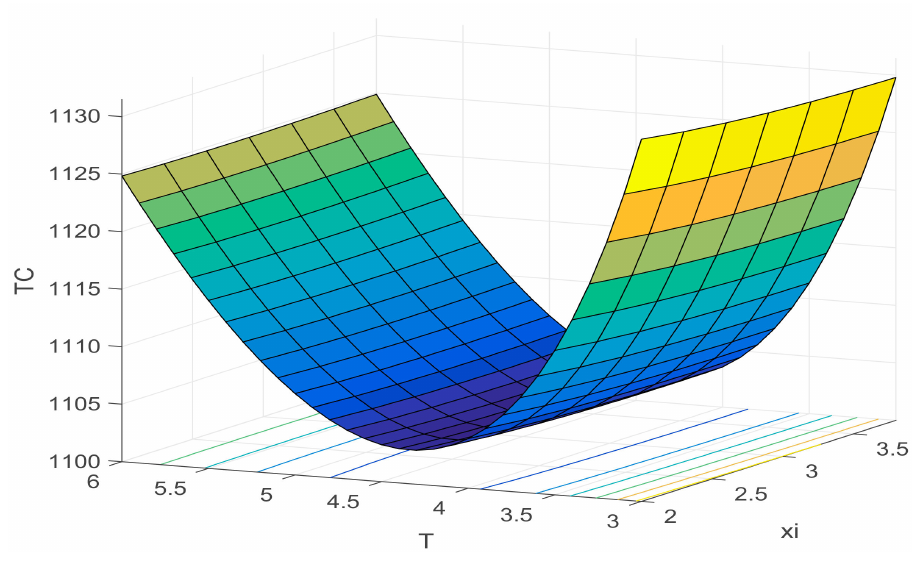
Figure 3. The relationship between T, ξ , and TC.